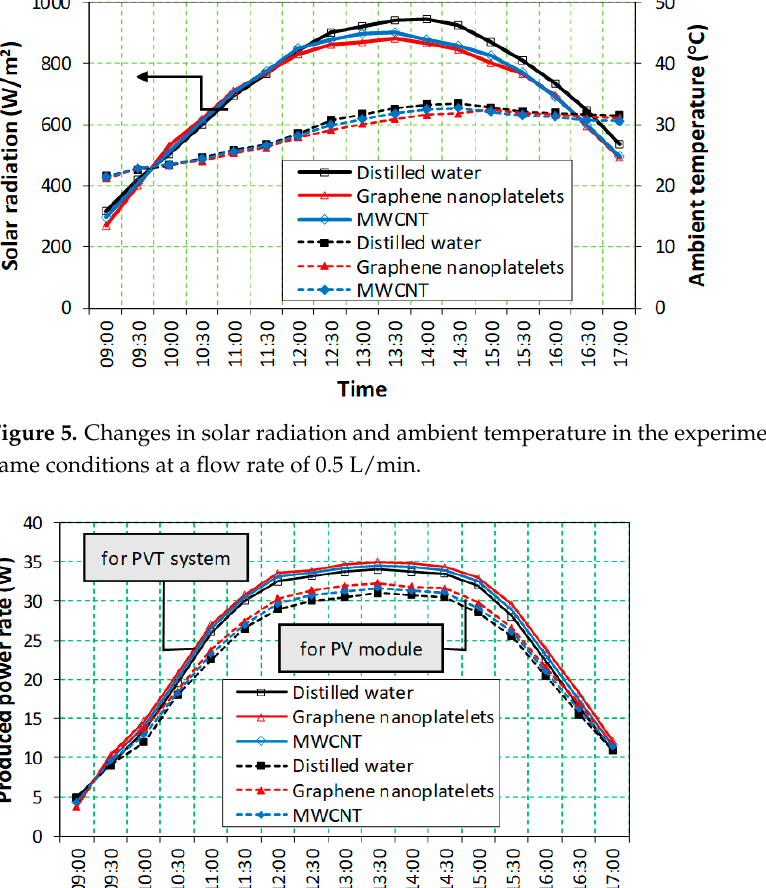
Figure 5. Changes in solar radiation and ambient temperature in the experiments selected with the same conditions at a flow rate of 0.5 L/min.